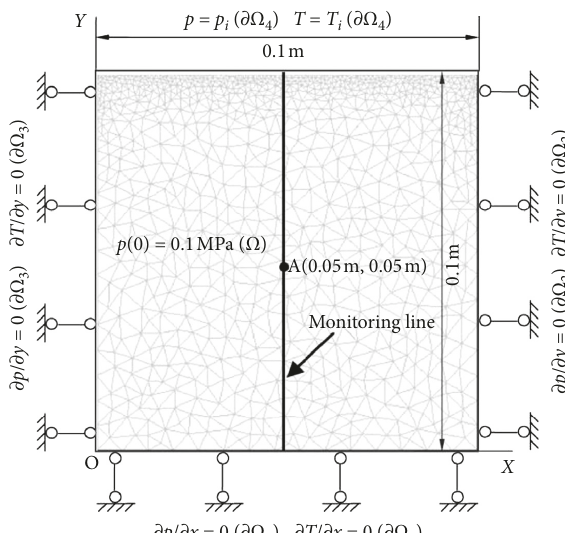
Figure 4: Calculation